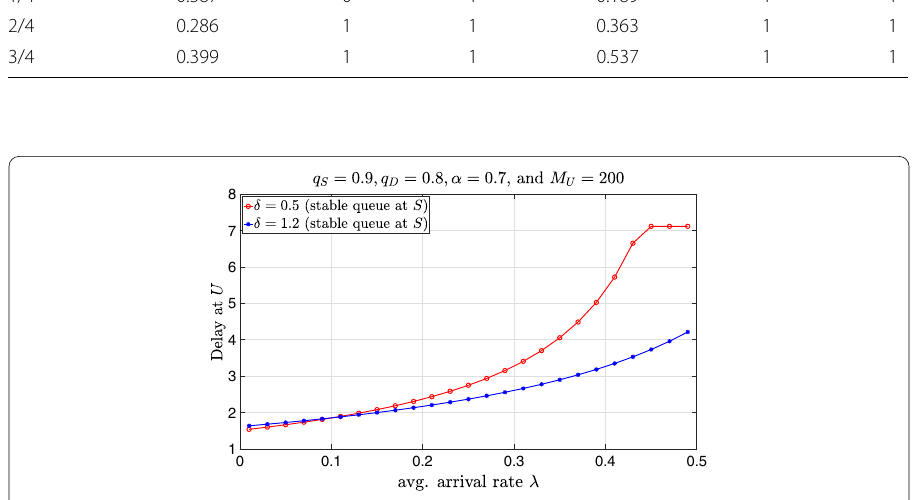
Fig. 10 The average delay at U vs. average arrival rate (cid:31) at S for δ ∈ { 0.5,1.2